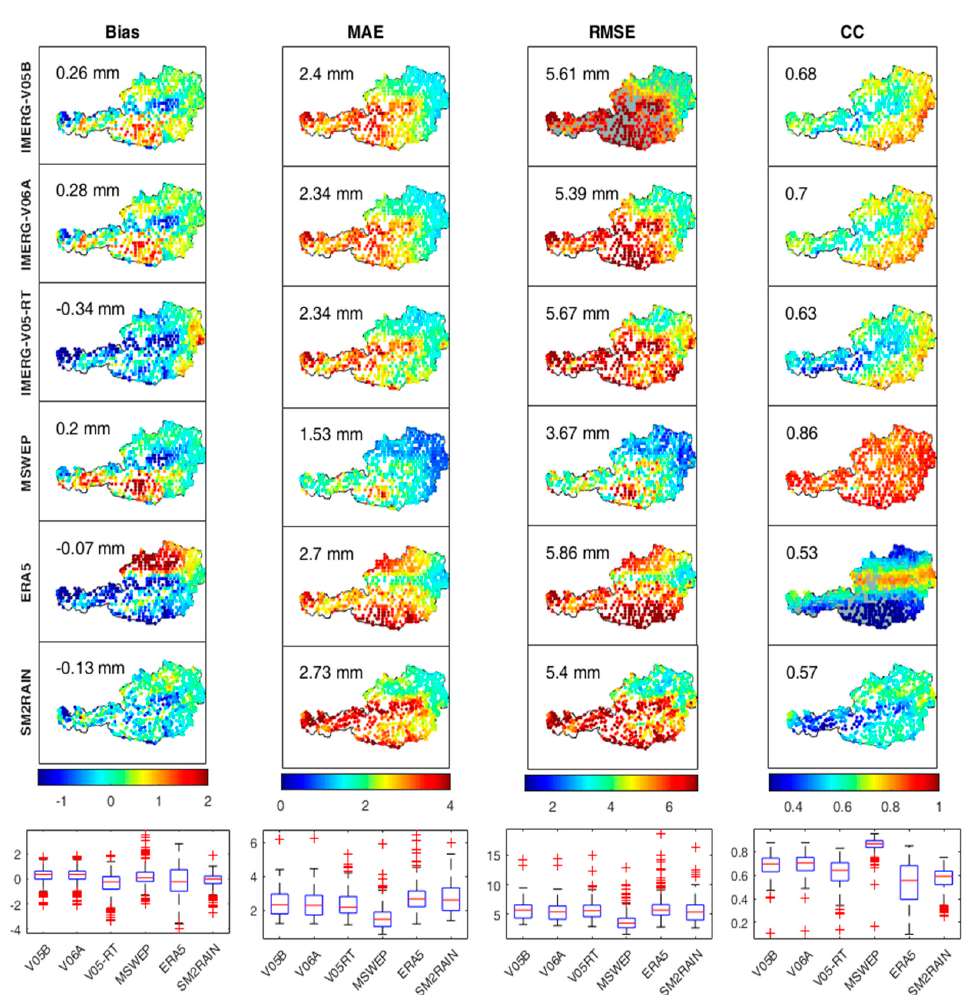
Figure 3. Statistical indices for bias, MAE, RMSE, and CC from left to right columns, respectively, at daily time scale for IMERG-V05, IMERG-V06A, IMERG-V05-RT, MSWEP, ERA5, and SM2RAIN. The center-line of each boxplot depicts the median value (50th percentile) and the box encompasses the 25th and 75th percentiles of the sample data, while the whiskers represent the extreme values, respectively.